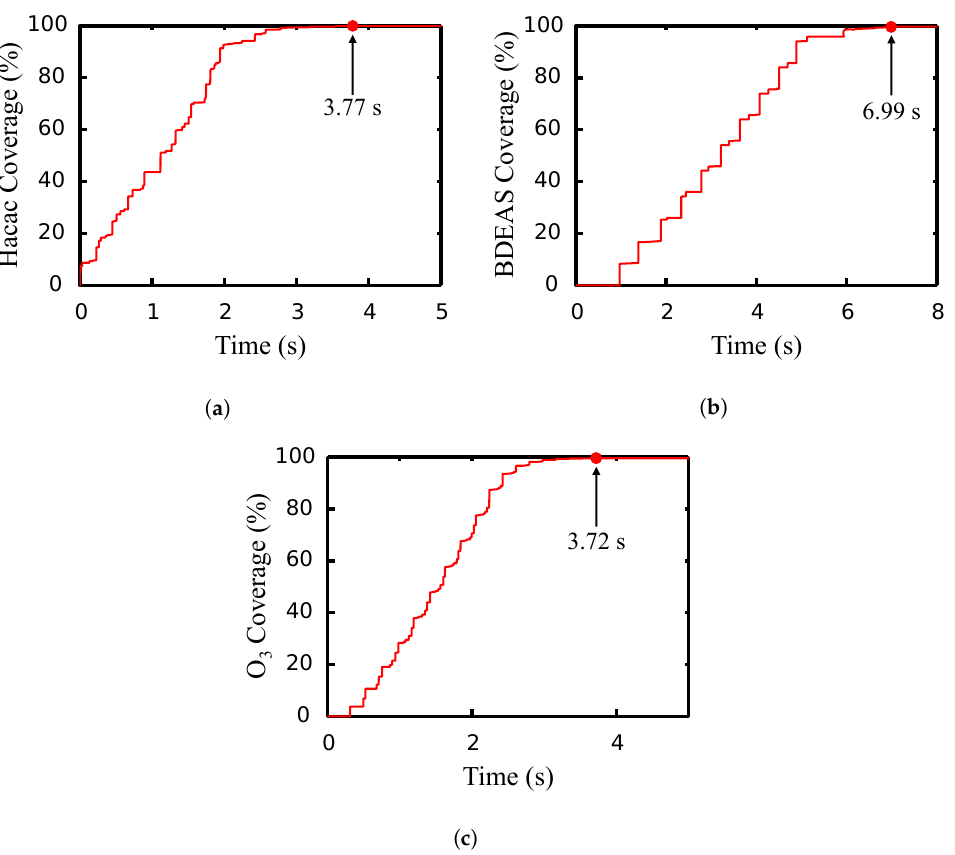
Figure 13. Multiscale CFD plots illustrating the surface coverage (%) progression as a function of time for ( a ) 0.1 mole fraction Hacac adsorption, ( b ) 0.5 mole fraction BDEAS adsorption, ( c ) 0.1 mole fraction O 3 adsorption. Evaluated multiscale process times to reach full surface coverage were longer than observed mesoscopic model process times conducted from prior work